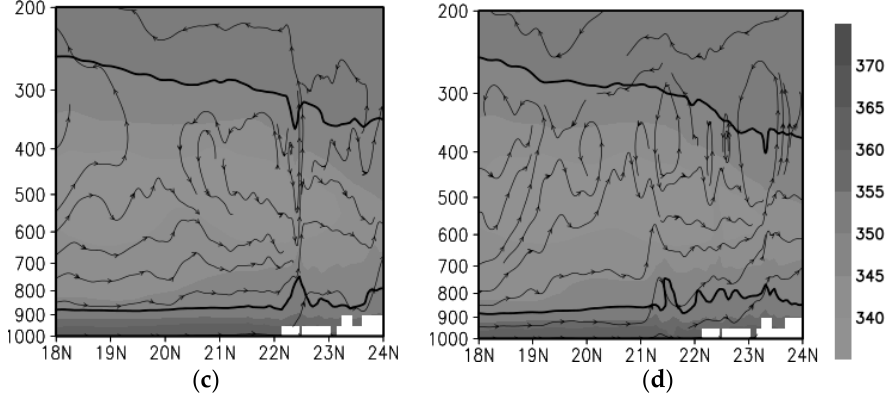
Figure 8. Vertical cross section corresponds to 114E of θ se (shaded every 5 K; the thick solid lines denote the distribution at 350 K) and the meridional wind from the D2 simulation valid at ( a ) 2000 and ( b ) 2200 UTC on 19 May and ( c ) 0000 and ( d ) 0200 UTC on 20 May.